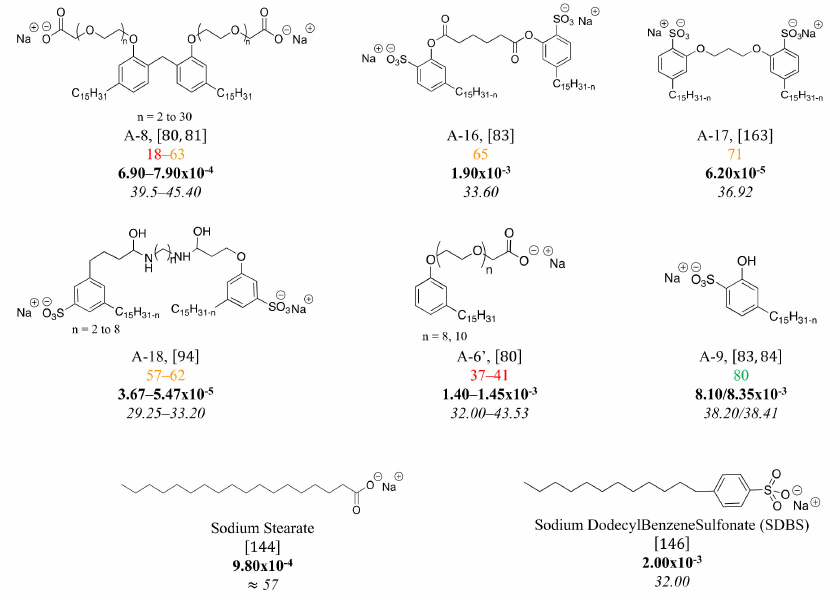
Figure 16. % bio (green for % up to 75%, red for % under 50% and orange in between (50–75%), CMC (mol/L, bold) and surface tension (mN/m, italics) of anionic Gemini CNSL-based surfactants, single-chain analogs, and commercial